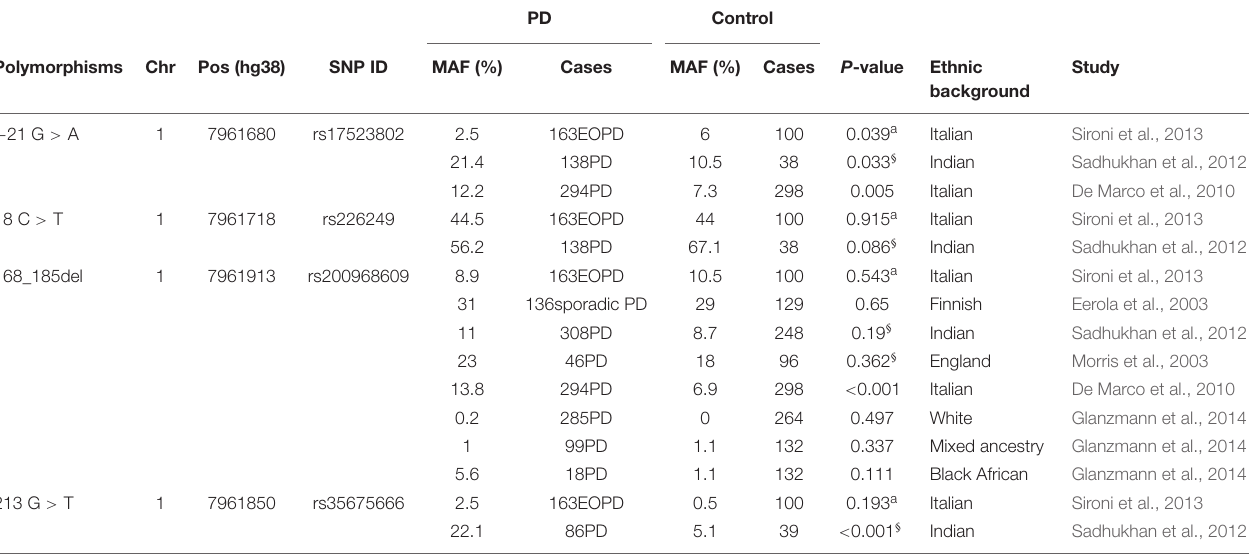
TABLE 6 | Detailed information of previous studies selected into